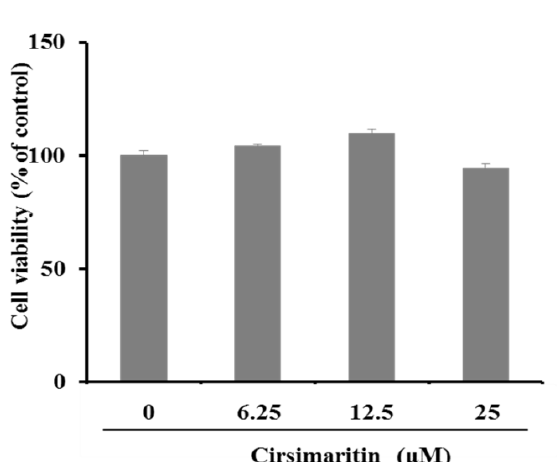
Figure 1. Effects of cirsimaritin on dendritogenesis and cell viability of murine B16F10 cells. Cells were treated with 0.1% ( v / v ) dimethylsulfoxide (DMSO) or various doses